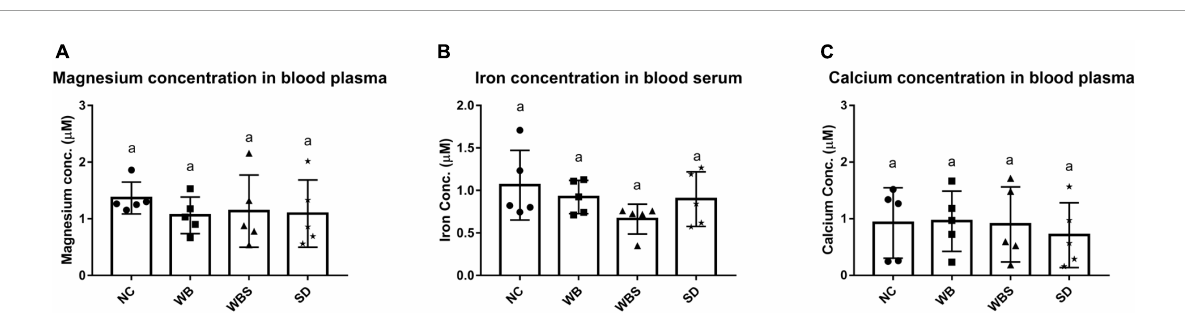
FIGURE3 Mineral bioavailability and absorption assay. (A) Magnesium concentration in mouse blood plasma in each group. (B) Iron concentration in mouse blood serum in each group. (C) Calcium concentration in mouse blood plasma in each group. Error bars present the standard deviations of five replicates ( n = 5 male mice) in each group. One-way ANOVA followed by Duncan’s post-hoc analysis, and bars with different letters indicate significant differences at p <